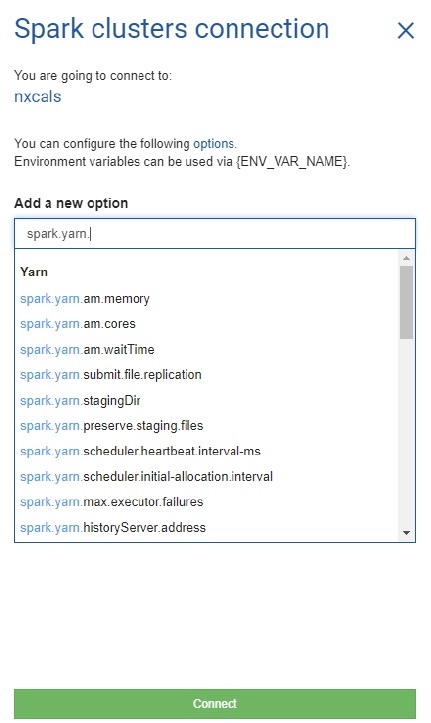
Figure 2: Spark Configuration Figure 3 : Configuration